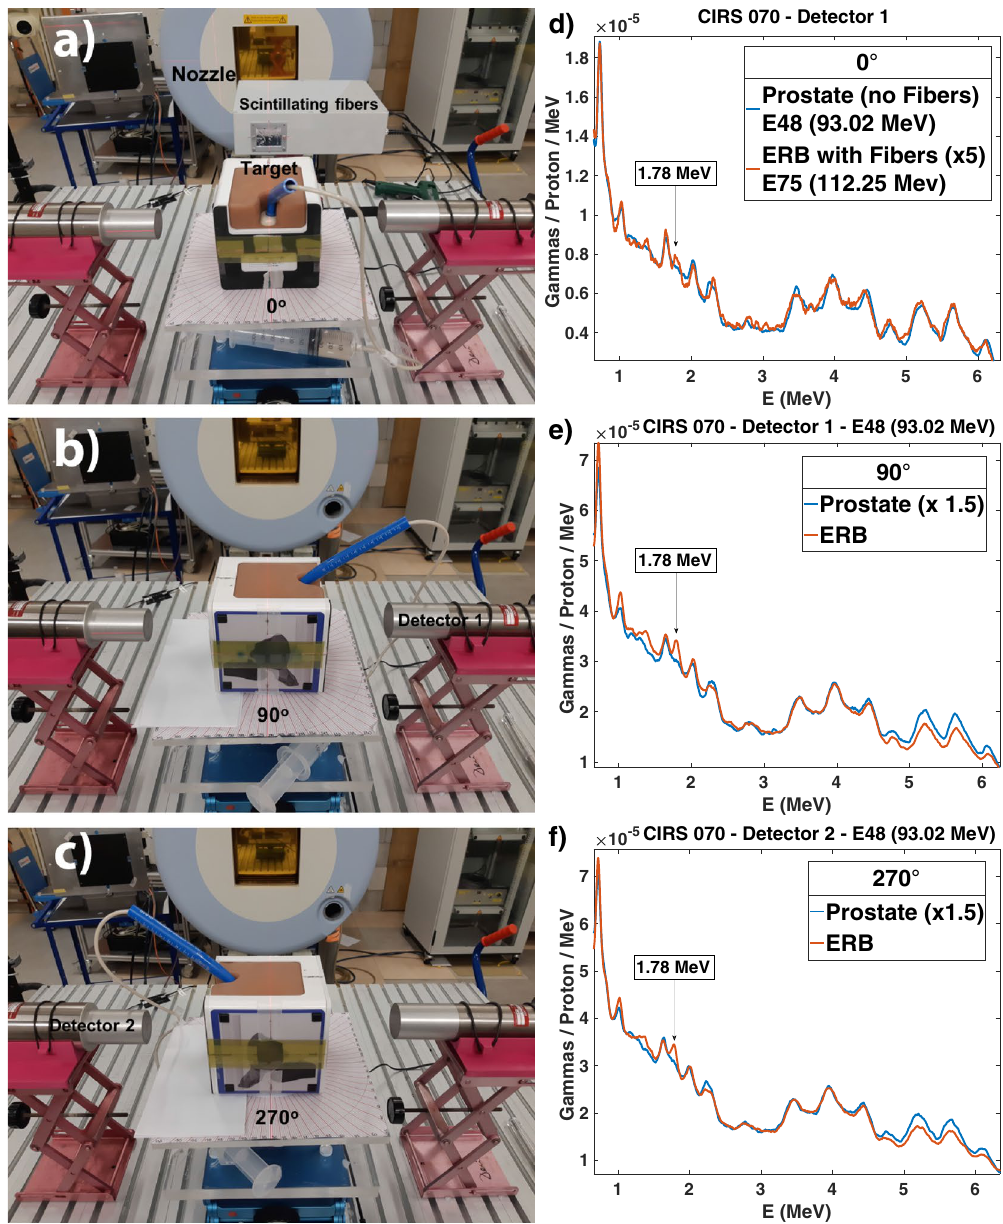
Figure 3. Prostate phantom irradiated at different gantry angles. ( a – c ) Photos of the prostate phantom with an ERB filled with SiO 2 and lying on a rotating platform to reproduce the three gantry angles of 0 ( d–f ), Energy spectra from the irradiation of the prostate and the rectal balloon at the three angles. The silicon energy peak of 1.78 MeV is clearly distinguishable in the ERB